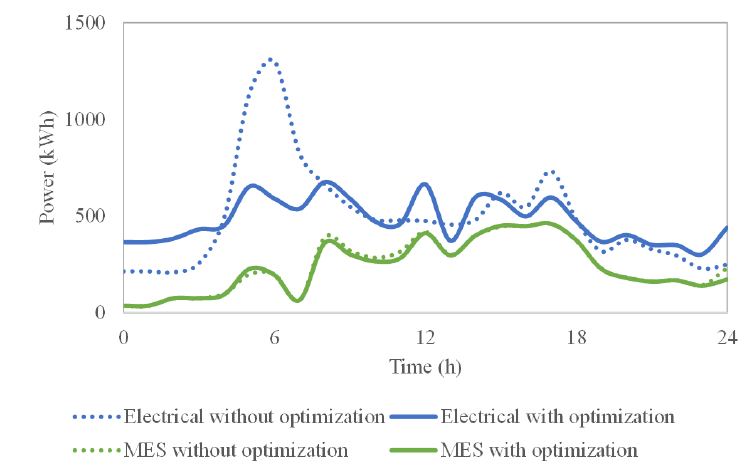
Figure 10. Power consumed in the network.